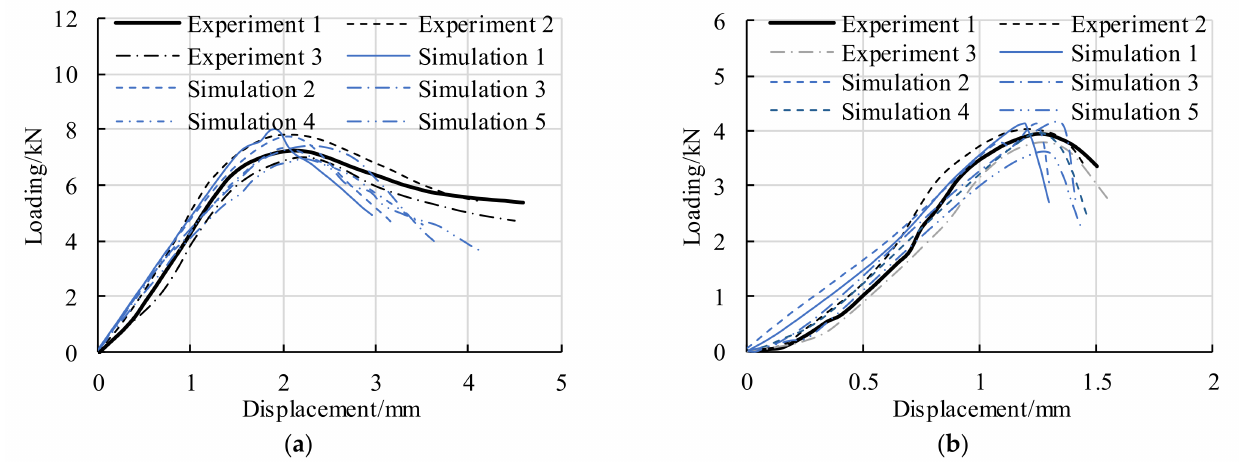
Figure 9. Loading–displacement curves of experiments vs simulations: ( a ) compression tests and ( b ) tensile tests.